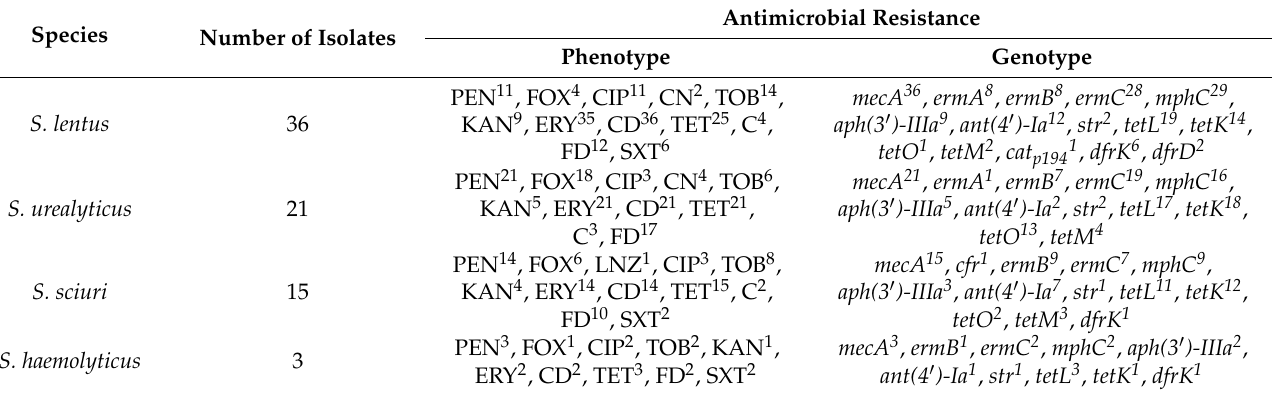
Table 2. Antimicrobial-resistant genes identified among the CoNS isolated from poultry.